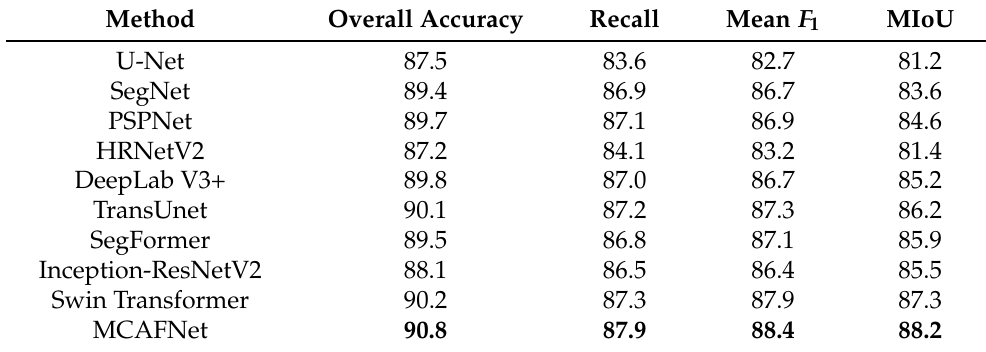
Table 2. The metrics (%) of the semantic segmentation models in the testing phase.